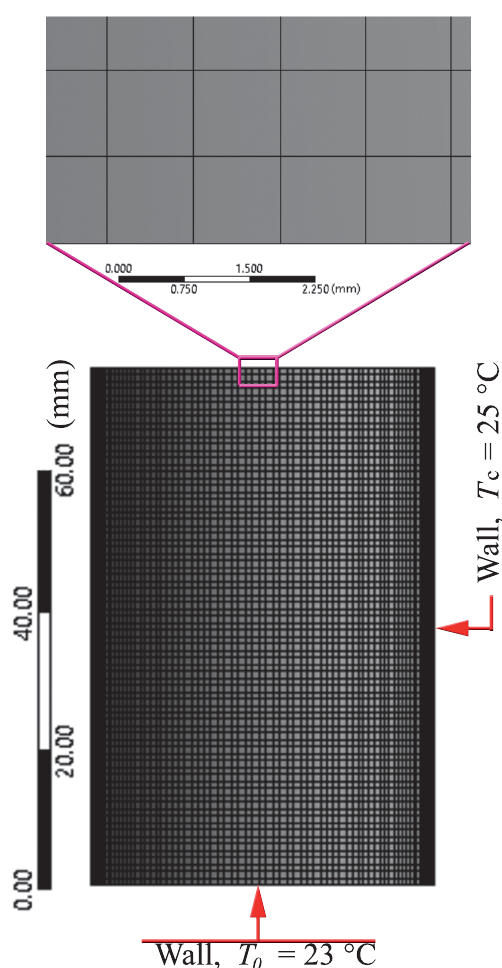
Figure 2. Mesh for the numerical